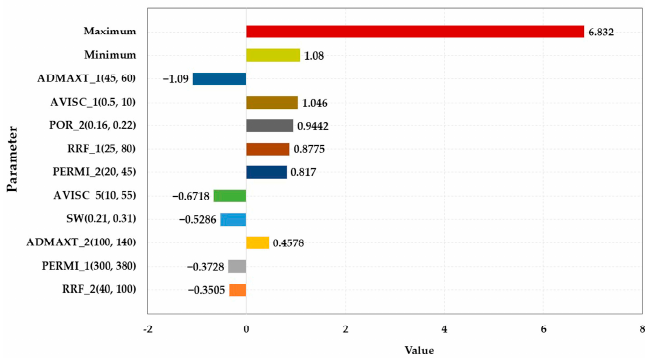
Figure 7. Parameter sensitivity analysis of the COP of the HPL.